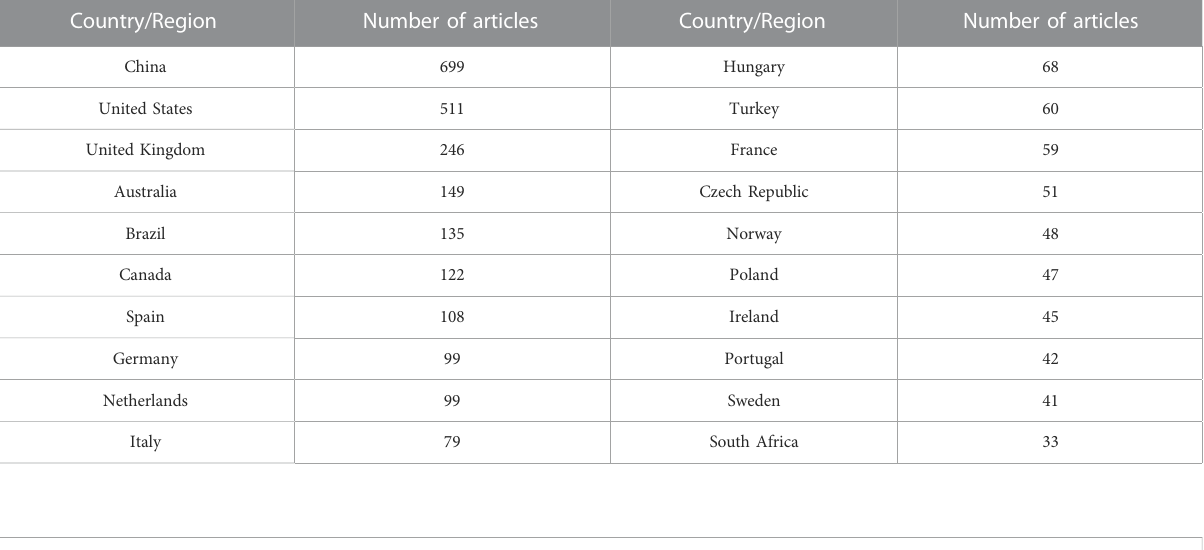
TABLE 3 Number of articles in rural settlements fi eld in different countries/regions published. Country/Region Number of articles Country/Region